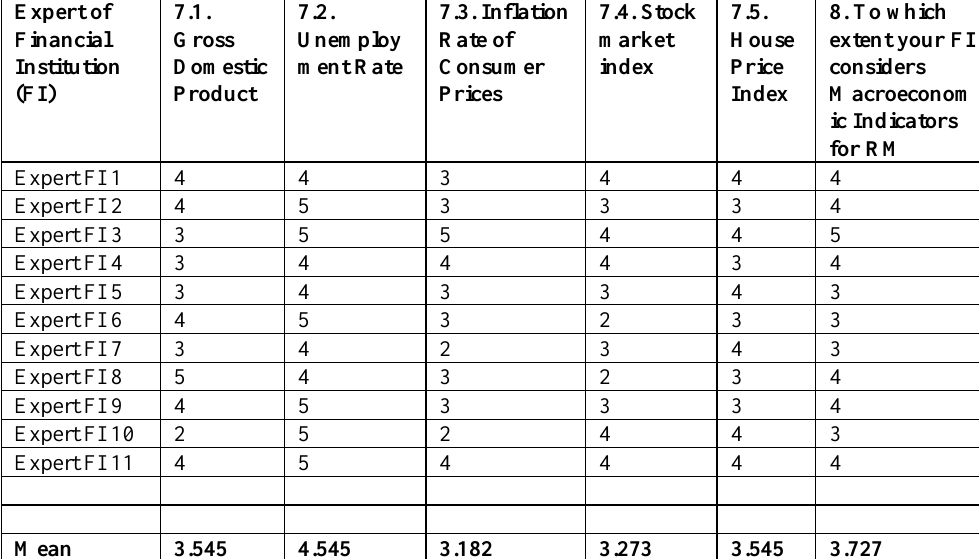
Table 4. Macroeconomic Indicators for Credit Defaults (developed by the